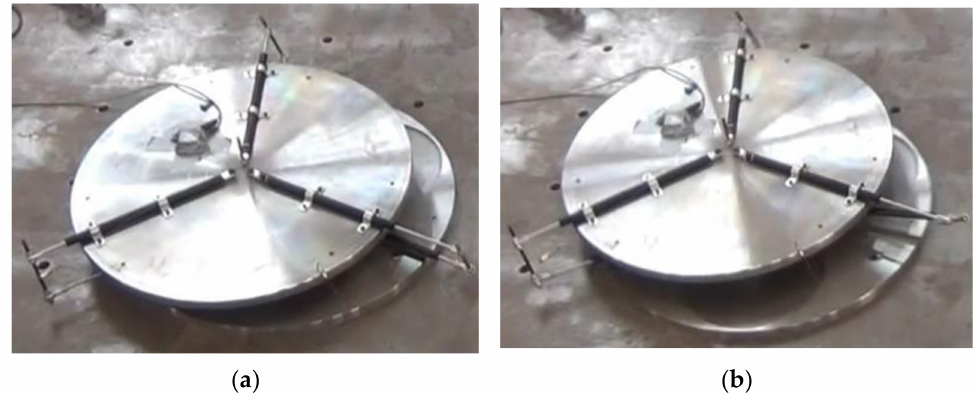
Figure 21. Maximum displacement response of the same device under 061CHC ground motion with ( a ) PGA = 1.4 m/s 2 and ( b ) PGA = 2 m/s 2